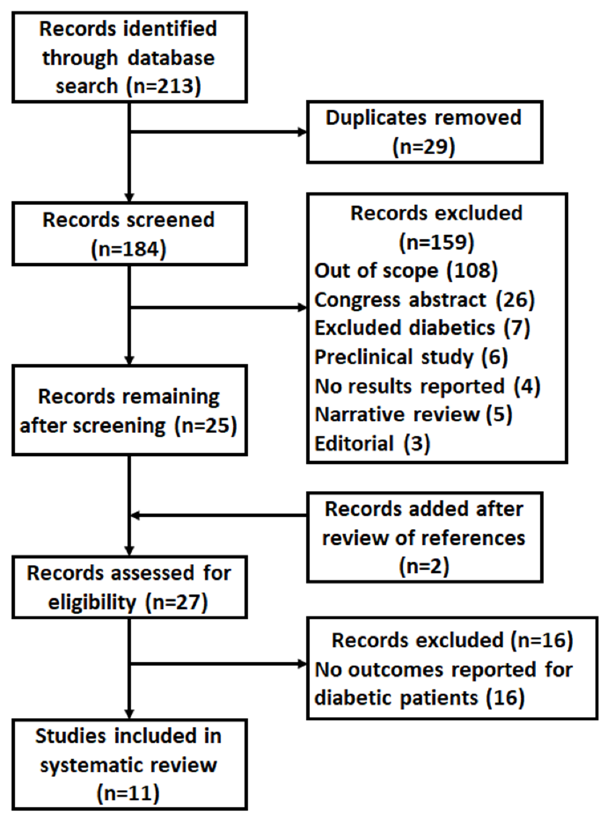
Figure 1. Preferred Reporting Items for Systematic Reviews and Meta-Analyses (PRISMA) study flow diagram.